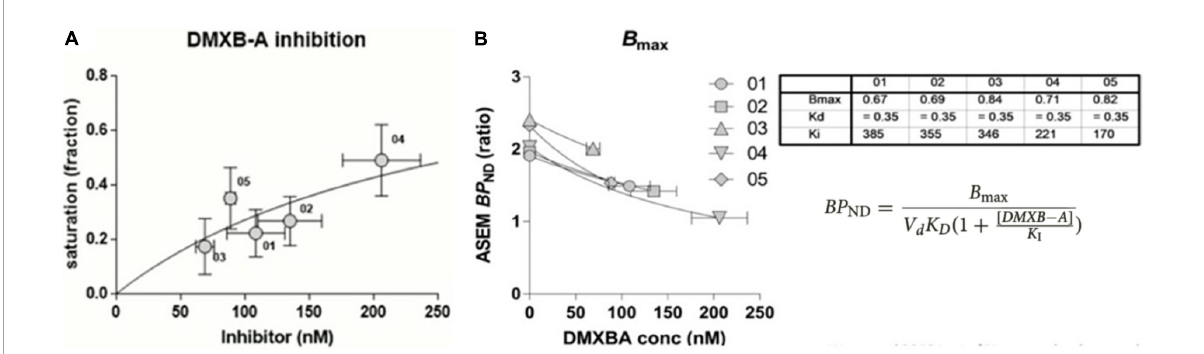
FIGURE12 Binding parameter estimates in absence of reference region. (A) Estimates by [ 18 F]ASEM of occupancy in humans of α 7 nAChR by pairs of BP ND at specific inhibitor DXMB-A concentrations. (B) Determination of B max and V d K D by means of Equation 68, listed in table for five healthy volunteers receiving single oral dose of DXMB-A (GTS-21) ( adapted from Wong et al.,